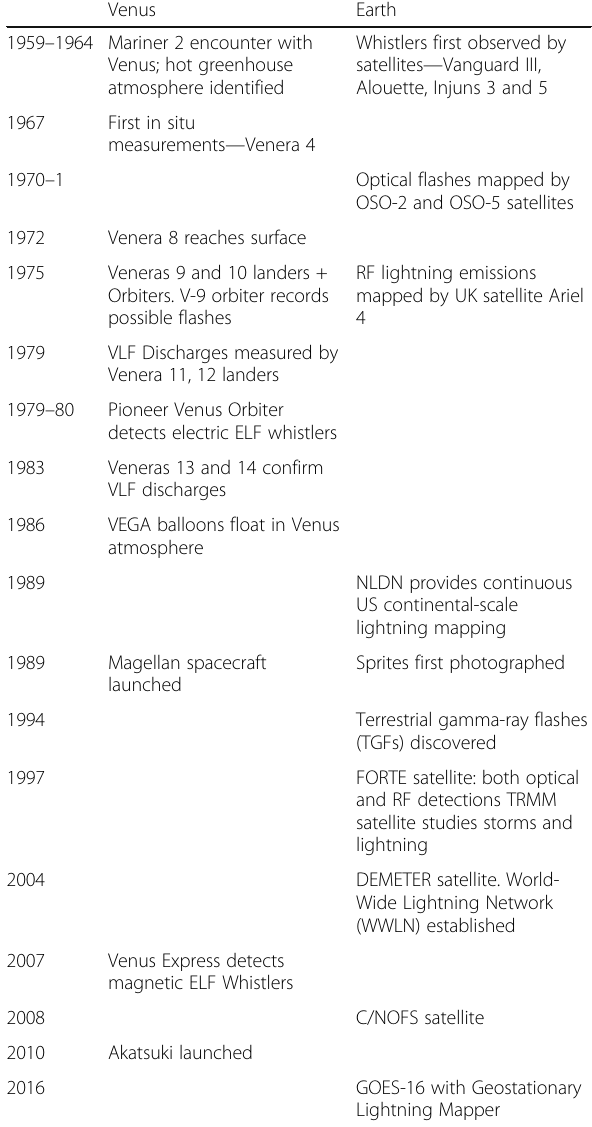
Table 1 Timeline of lightning studies. Venus dates correspond to relevant publications, rather than data acquisition, generally only a year or so